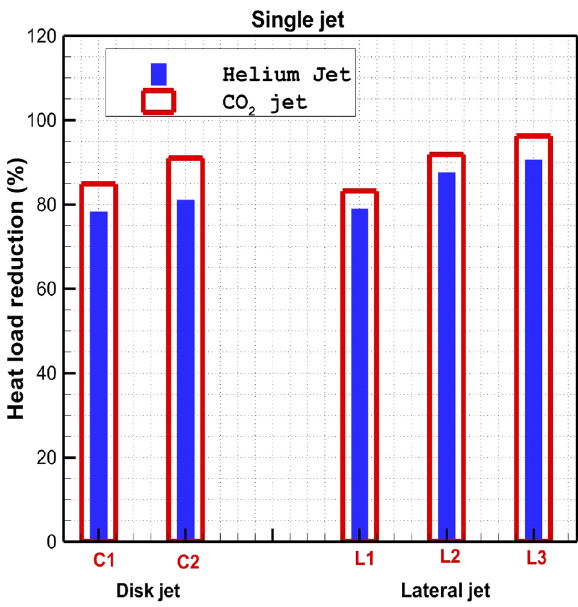
Figure 9. Comparison of heat load reduction of the different lateral coolant injection